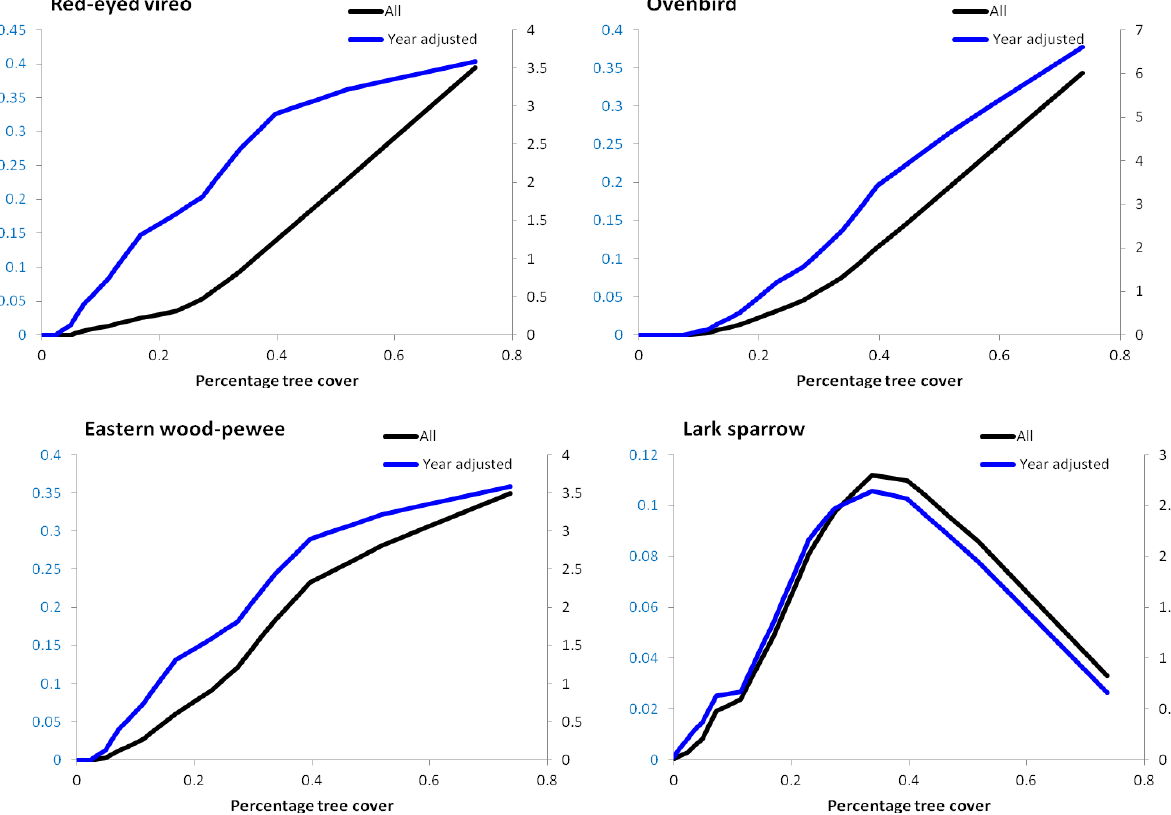
Figure A1.5 Standard (1/0) and year-adjusted results for four species unevenly distributed among